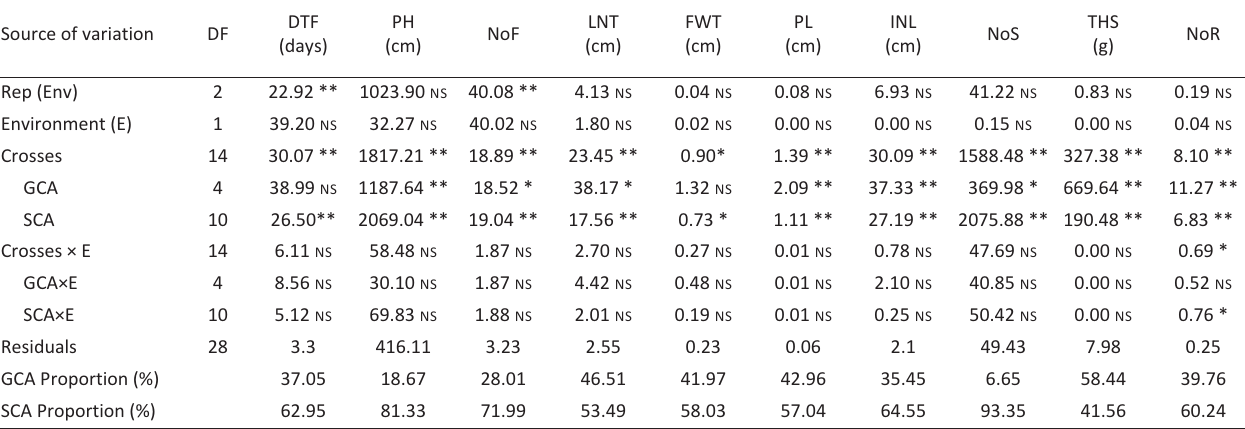
*,** significant at p≤0.05 and p≤0.01, respectively; NS = not significant; Rep= Replicate; DTF= days to 50% flowering; PH= plant height at